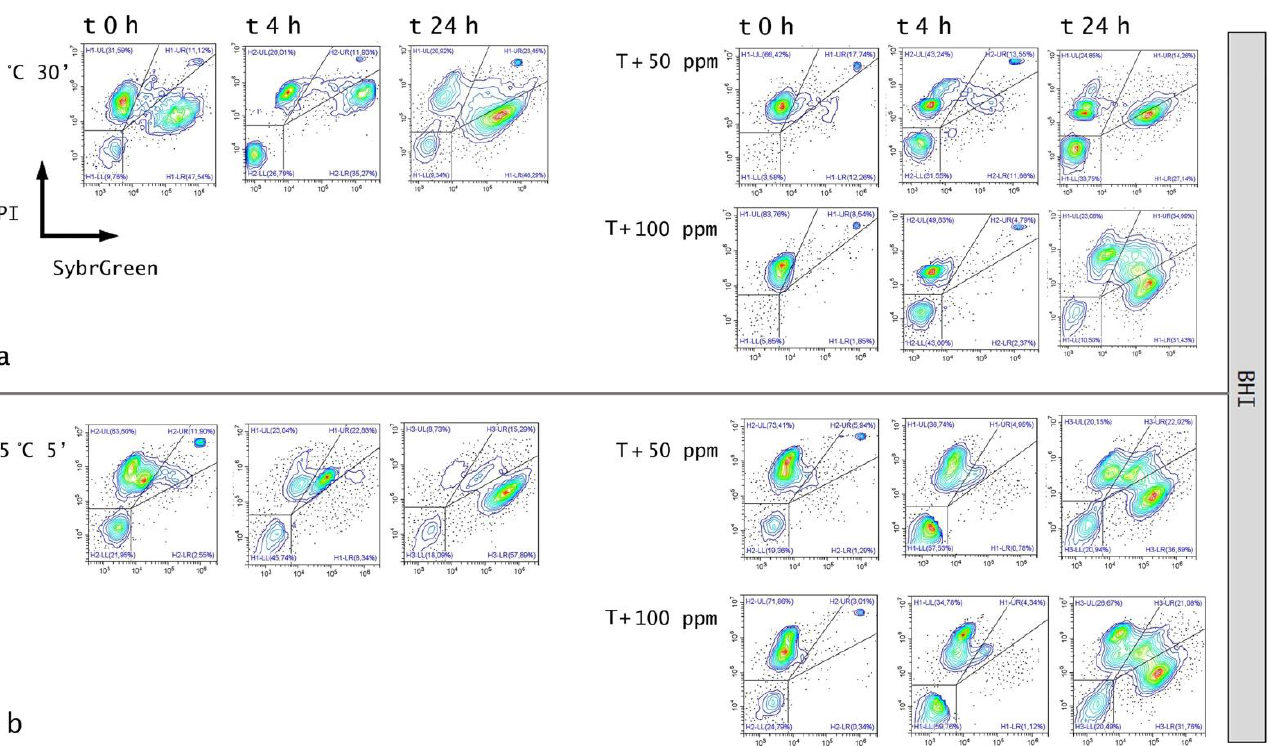
Figure 6. Double-staining density dot plot of E. coli cells in BHI broth diluted in PBS (pH 7.4): ( a ) combined thermal treatment at 55 °C 30’ and ( b ) 65 °C with or without OEO (50 and 100 ppm) at 0, 4, and 24 h of incubation, compared to thermal treatment alone. Cells were stained with SYBR-Green I and PI simultaneously. H1-LL: unstained debris; H1-LR: intact cells/viable cells (SYBR Green I); H1-UR: injured cell population; H1-UL: permeabilized/dead cells (PI). In the upper right side of the plot, a defined single population represents standard beads.